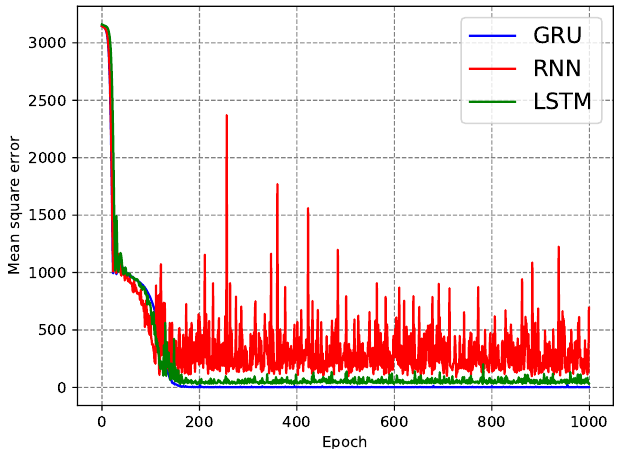
Figure 3. Training loss of RNN, RNN-Gate Recurrent Unit (GRU), and RNN-Long Short-Term Memory